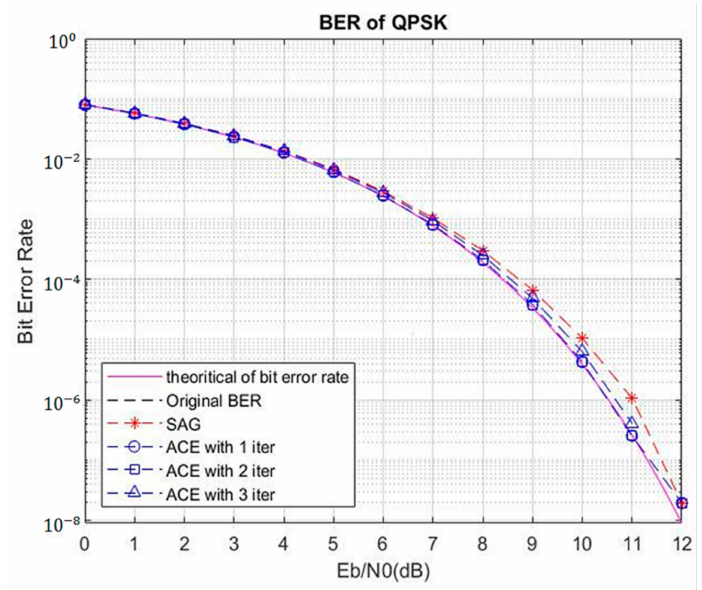
Figure 8. BER performance of the QPSK–OFDM with the SAG method compared with the ACE